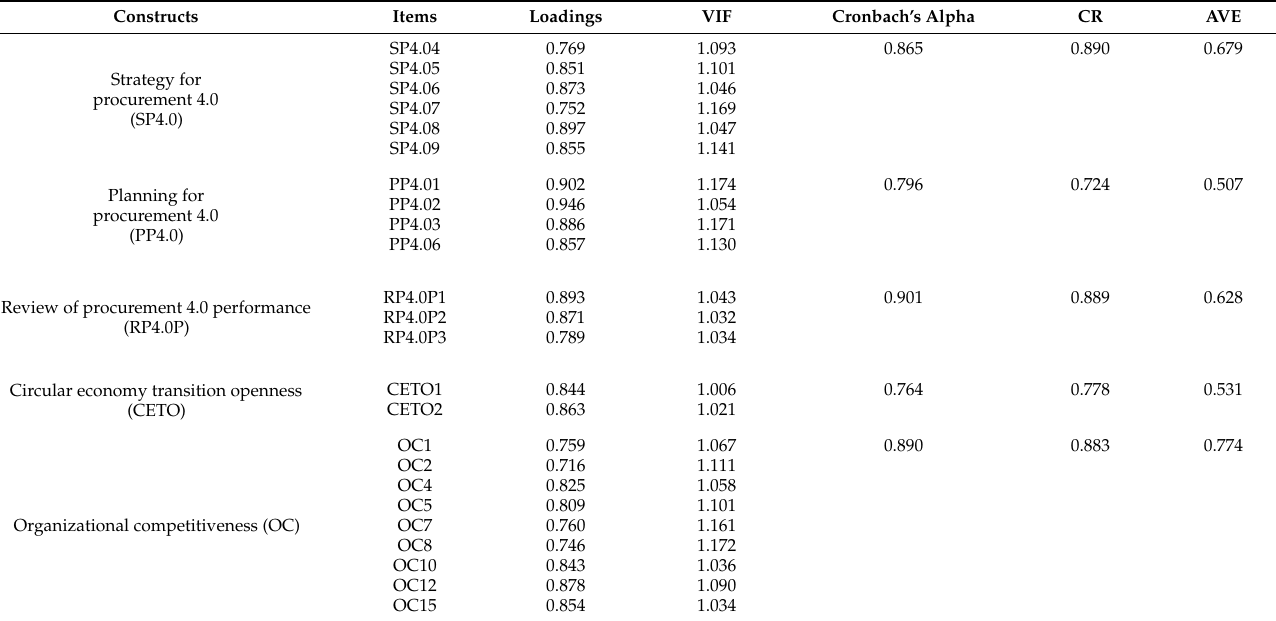
Table 2. Convergent validity, reliability, and item